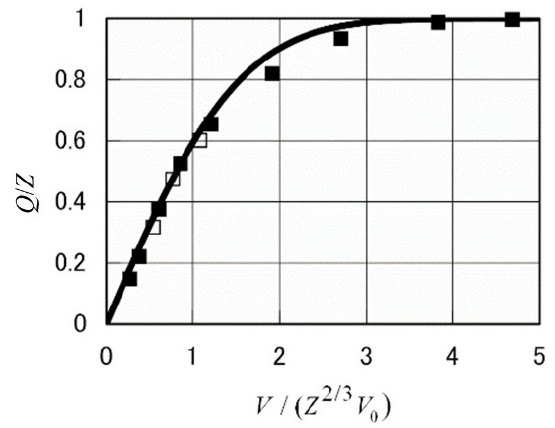
The formula including the activation energy is also presented [14]. Figure 4 shows the calculated value of the average charge of single-atom ions as a function of the reduced speed. It displays a good agreement with the experimental data.